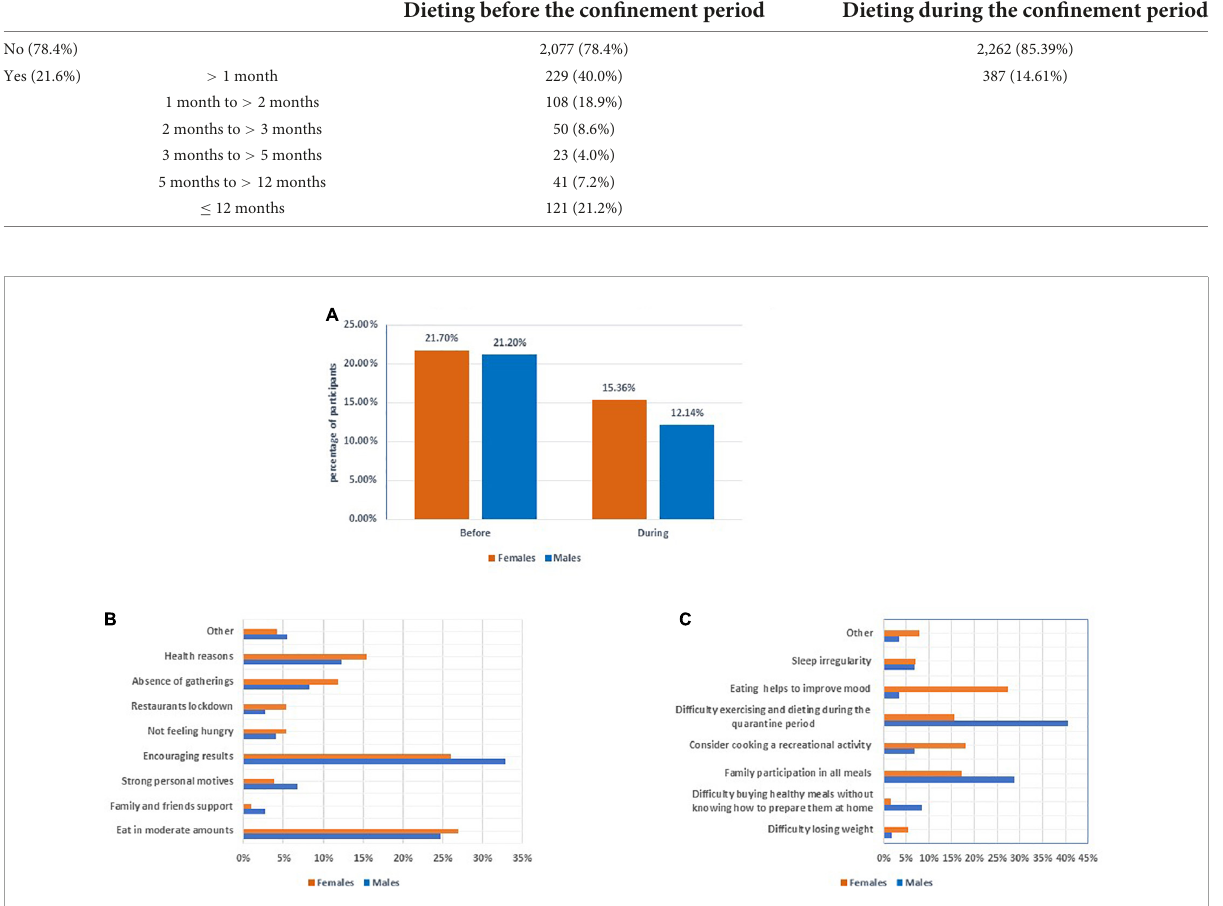
FIGURE1 Gender differences in dieting during the confinement period. (A) Follow the diet according to gender before and during the confinement period. (B) Causes to continuing following healthy diet during the confinement period. (C) Causes to stopping following healthy diet during the confinement period.